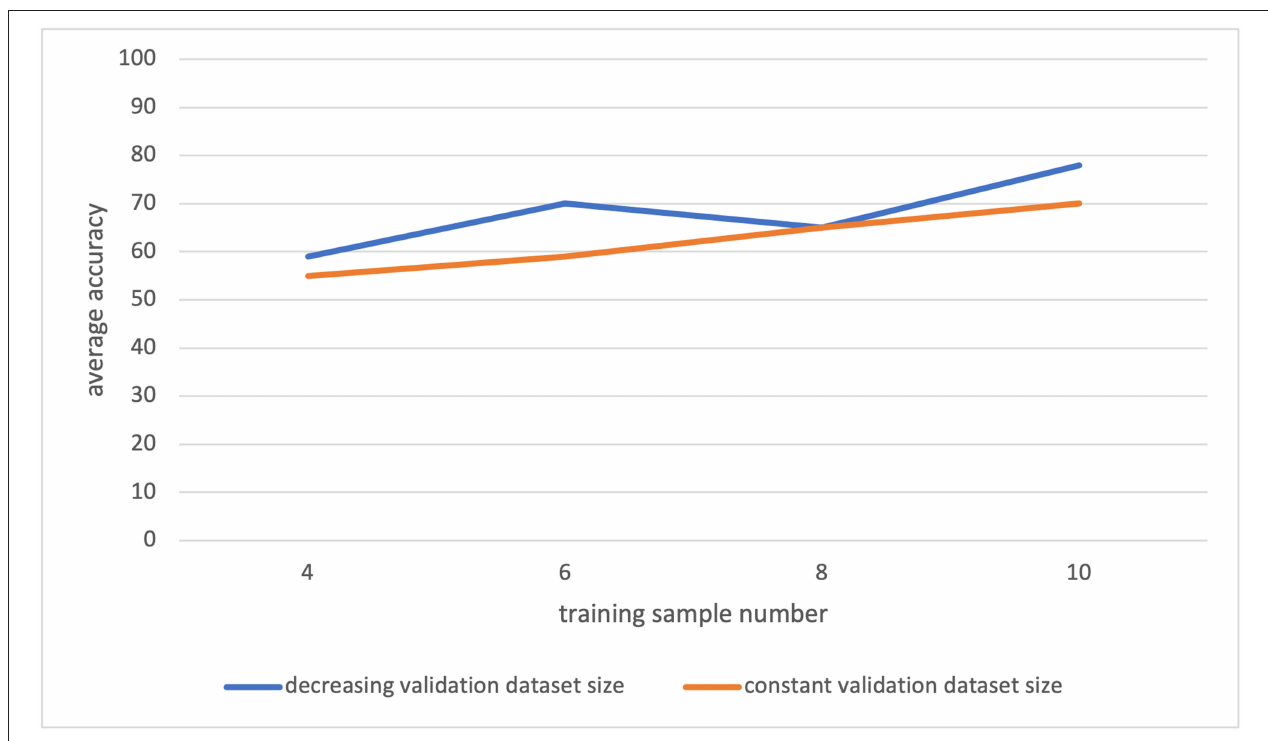
FIGURE 7 | The leave-one-out classification result for varying training and validation dataset sizes. The orange plot: for different training dataset sizes, the validation dataset is always formed by two samples. The blue plot: for different training dataset sizes, the validation dataset is formed as the remaining samples after the test and training sets are